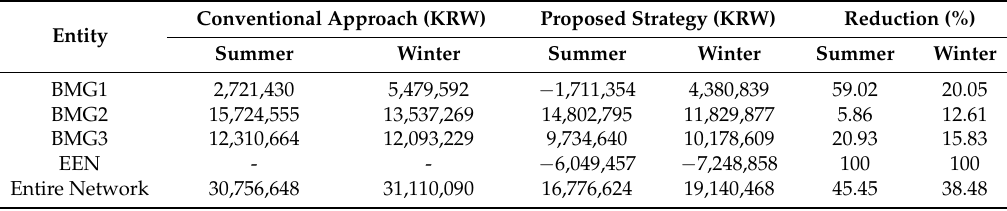
Table 4. Operation cost of the conventional approach and the proposed strategy in different